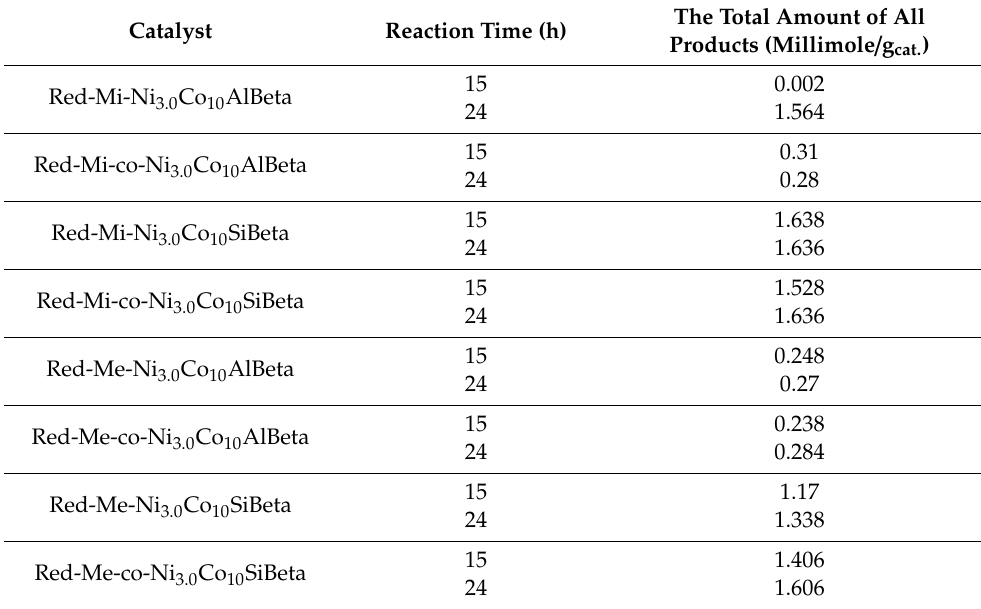
Table 4. The total amount of all products (millimole per gram of catalysts) calculated on the base of carbon balance data and CO